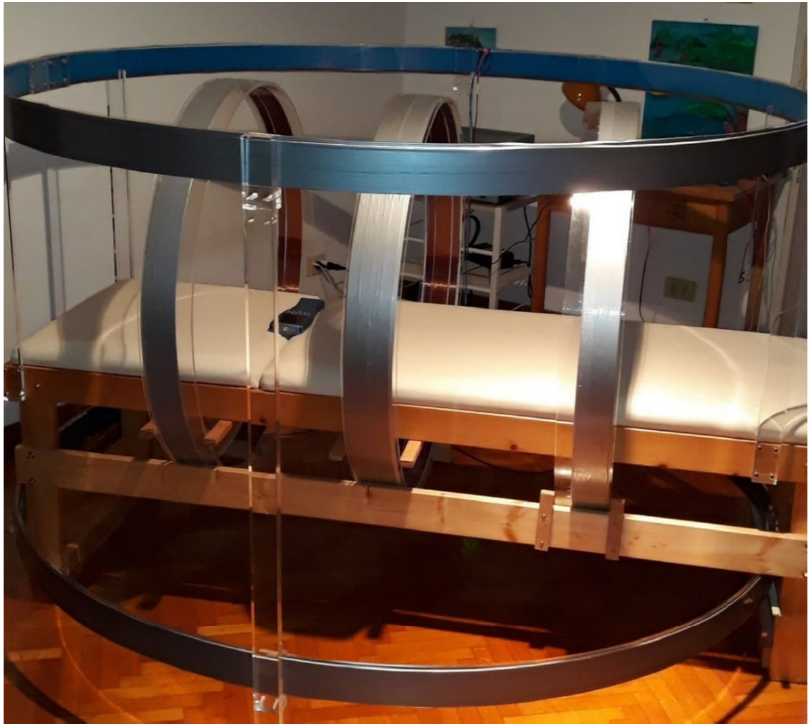
Figure 1. MED CRI device for cyclotron electromagnetic treatment. The value of the vector component south–north of the geomagnetic field, parallel to the powered alternating magnetic field, was increased by creating a stronger static magnetic field (40 μT), in the same direction of the alternating field. The selected ion cyclotron frequencies for tests were computed as in Equation (1).